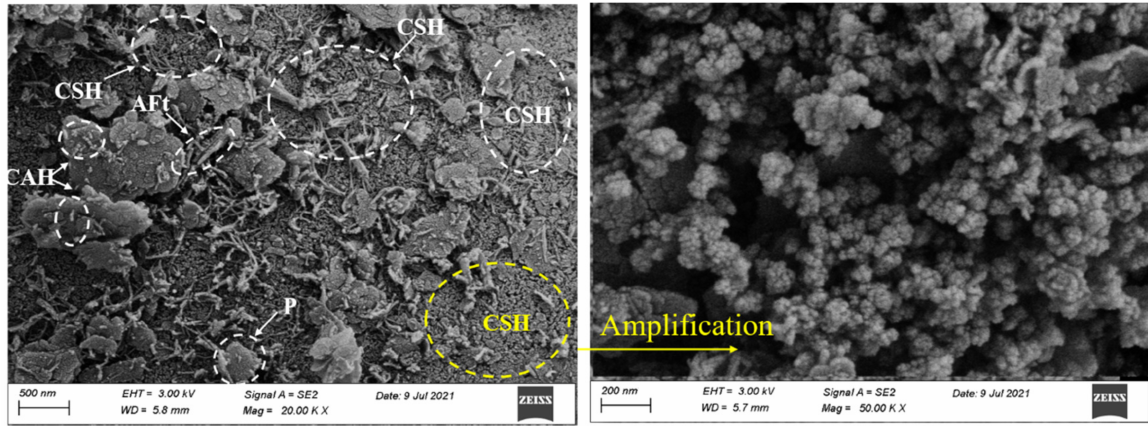
Figure 13. SEM images of CSH